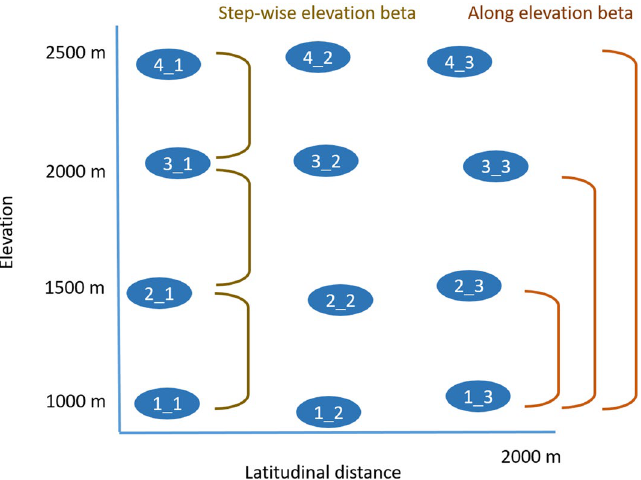
Figure 1. Study design with visualization of along and step-wise elevation beta diversity approach. Beta diversity components turnover and nestedness were calculated for all possible pairs and further distinguished between (i) along elevation beta diversity accounting for pairs starting from the lowest elevation to all other elevations (1,000–1,500, 1,000–2,000, 1,000–2,500 m a.s.l.), and (ii) step-wise beta diversity including pairs from one elevation to the next neighboring one (1,000–1,500, 1,500–2,000, 2,000–2,500 m). Each elevation was surveyed with three replicate sites (n total =